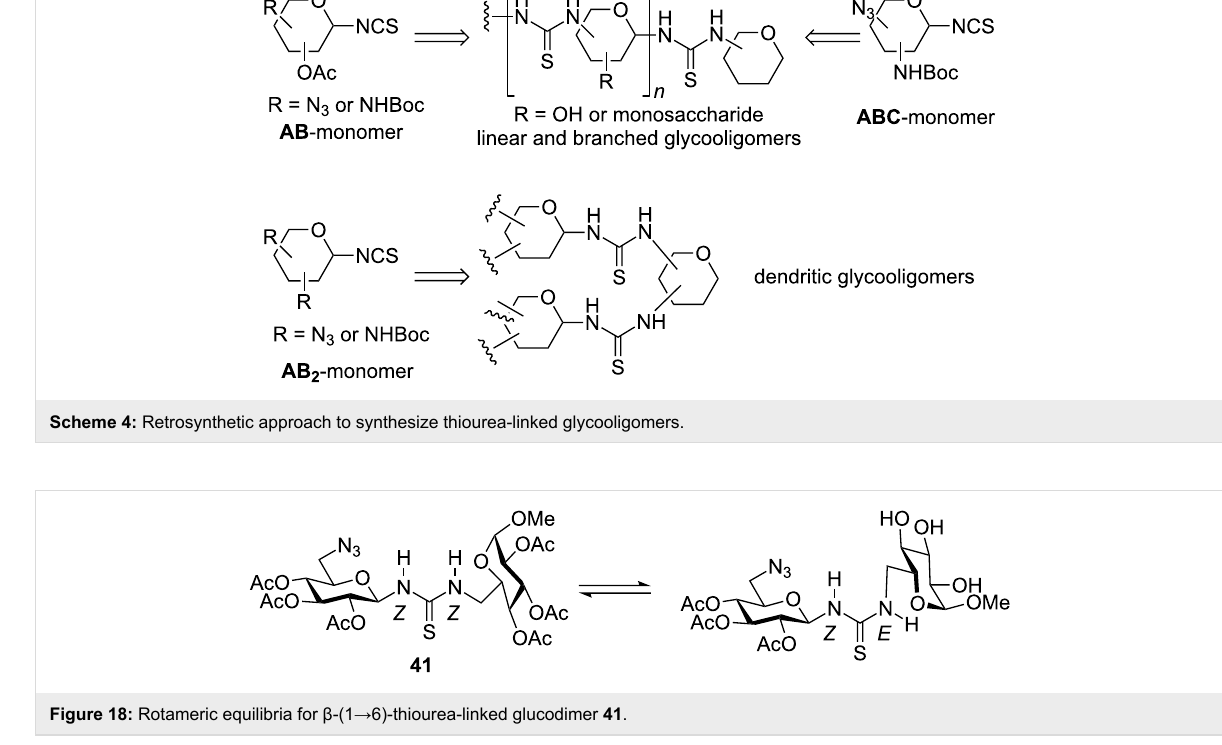
Molecular modelling predicts the existence of a flexible, relat- ively hydrophobic cavity suited for molecular inclusion of non- polar guests [79,88]. NMR supports this fact and confirms the high symmetry of these hosts, where all glucopyranosyl units are magnetically equivalent as in the case of cyclodextrins. De- termination of the inclusion capabilities towards a series of structurally diverse guests demonstrated that large-ring CTs are well suited for forming supramolecular complexes in water